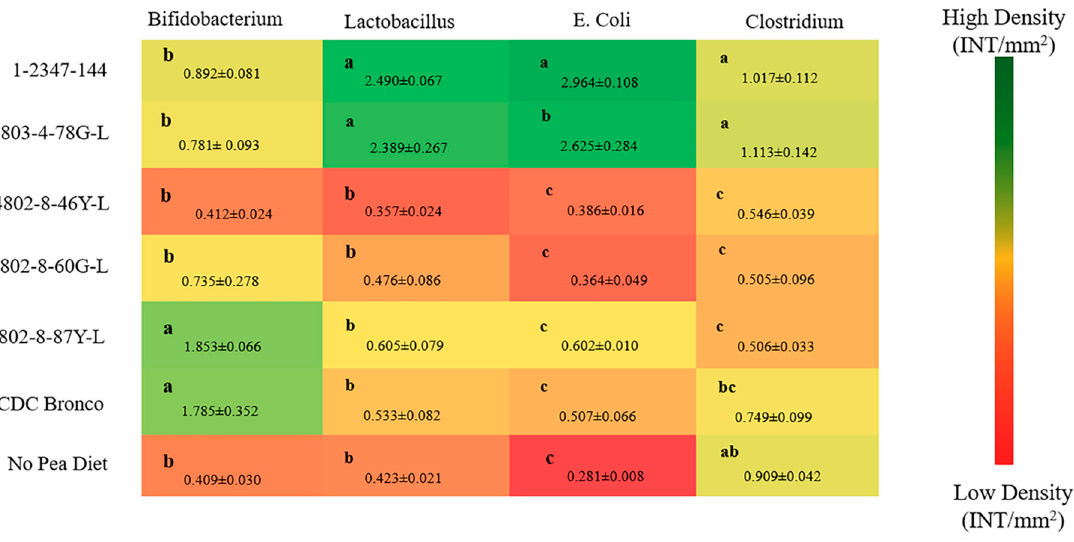
Figure 3. Genus- and species-level bacterial populations (AU) from cecal contents after six weeks of consuming pea-based diets. Values are means ± SEM ( n = 10 per treatment group). a–c Treatment groups not indicated by the same letter are significantly di ff erent ( p <